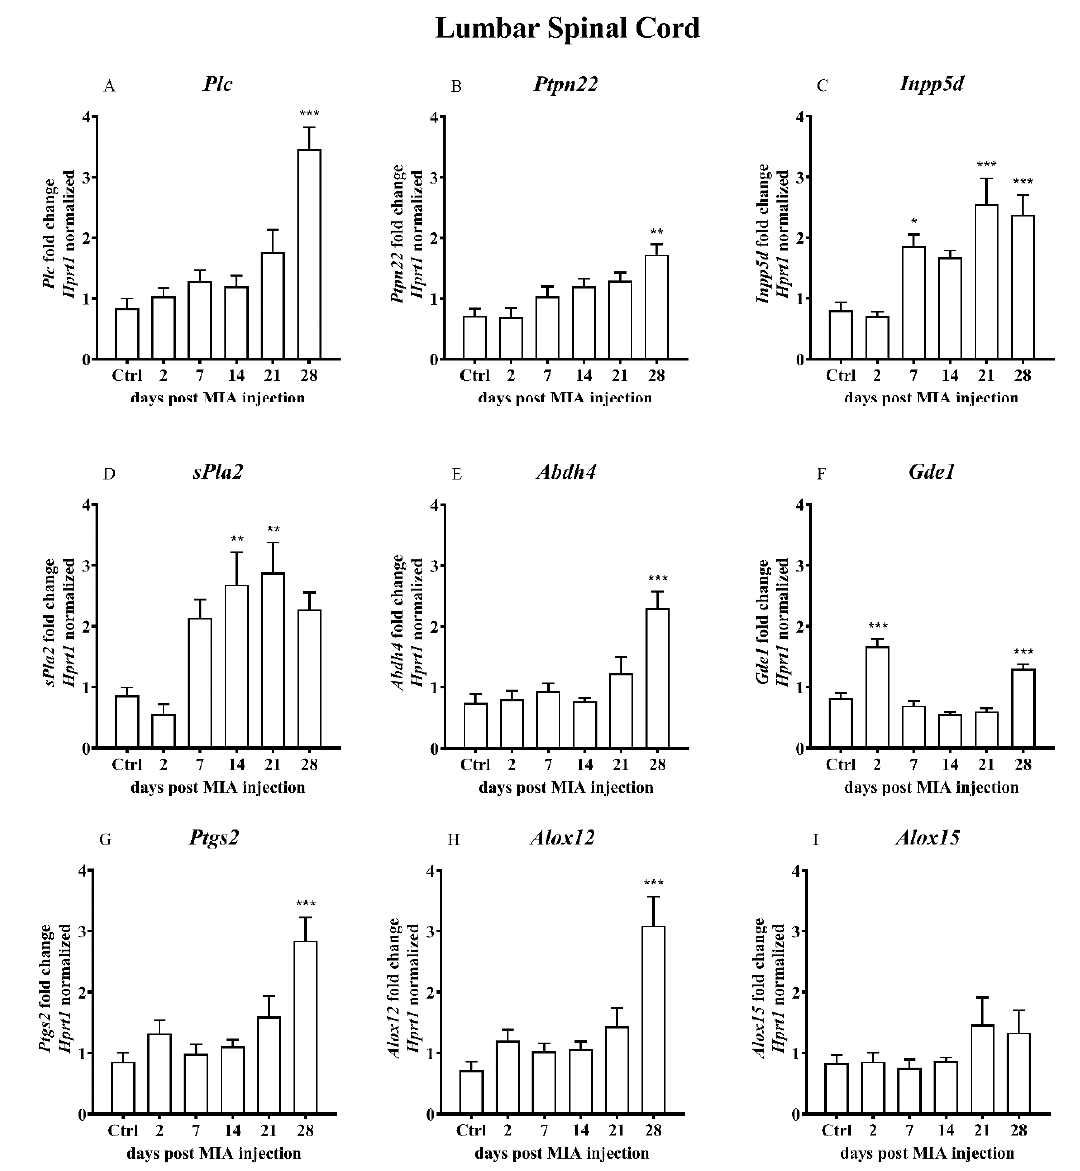
Figure 5. Transcript levels of the alternative AEA synthesis and degradation pathways ( A – I ), including phospholipase C ( Plc ), protein tyrosine phosphatase, non-receptor type 22 ( Ptpn22 ), inositol polyphosphate-5-phosphatase D ( Inpp5d ), phospholipase A2 ( sPla2g2a ), β hydrolase domain containing protein 4 ( Abdh4 ), glycerophosphodiester phosphodiesterase 1 ( Gde1 ), prostaglandin-endoperoxide synthase 2 ( Ptgs2 ), arachidonate 12-lipoxygenase ( Alox12 ) and arachidonate 15-lipoxygenase ( Alox15 ), in the lumbar L4–L6 spinal cord segments of rats after 3 mg MIA injection during OA development. Samples were collected 2, 7, 14, 21 and 28 days after MIA injection; the control group did not receive any treatment. The groups contained 6–9 samples. Data are presented as the mean ± SEM of fold changes of the group average normalized versus the reference gene ( Hprt1 ). Statistical analysis was performed using one-way ANOVA followed by Dunnett post hoc-test (intact animals treated as a control group). * denotes p < 0.05; ** denotes p < 0.01; *** denotes p < 0.001 vs. intact animals.